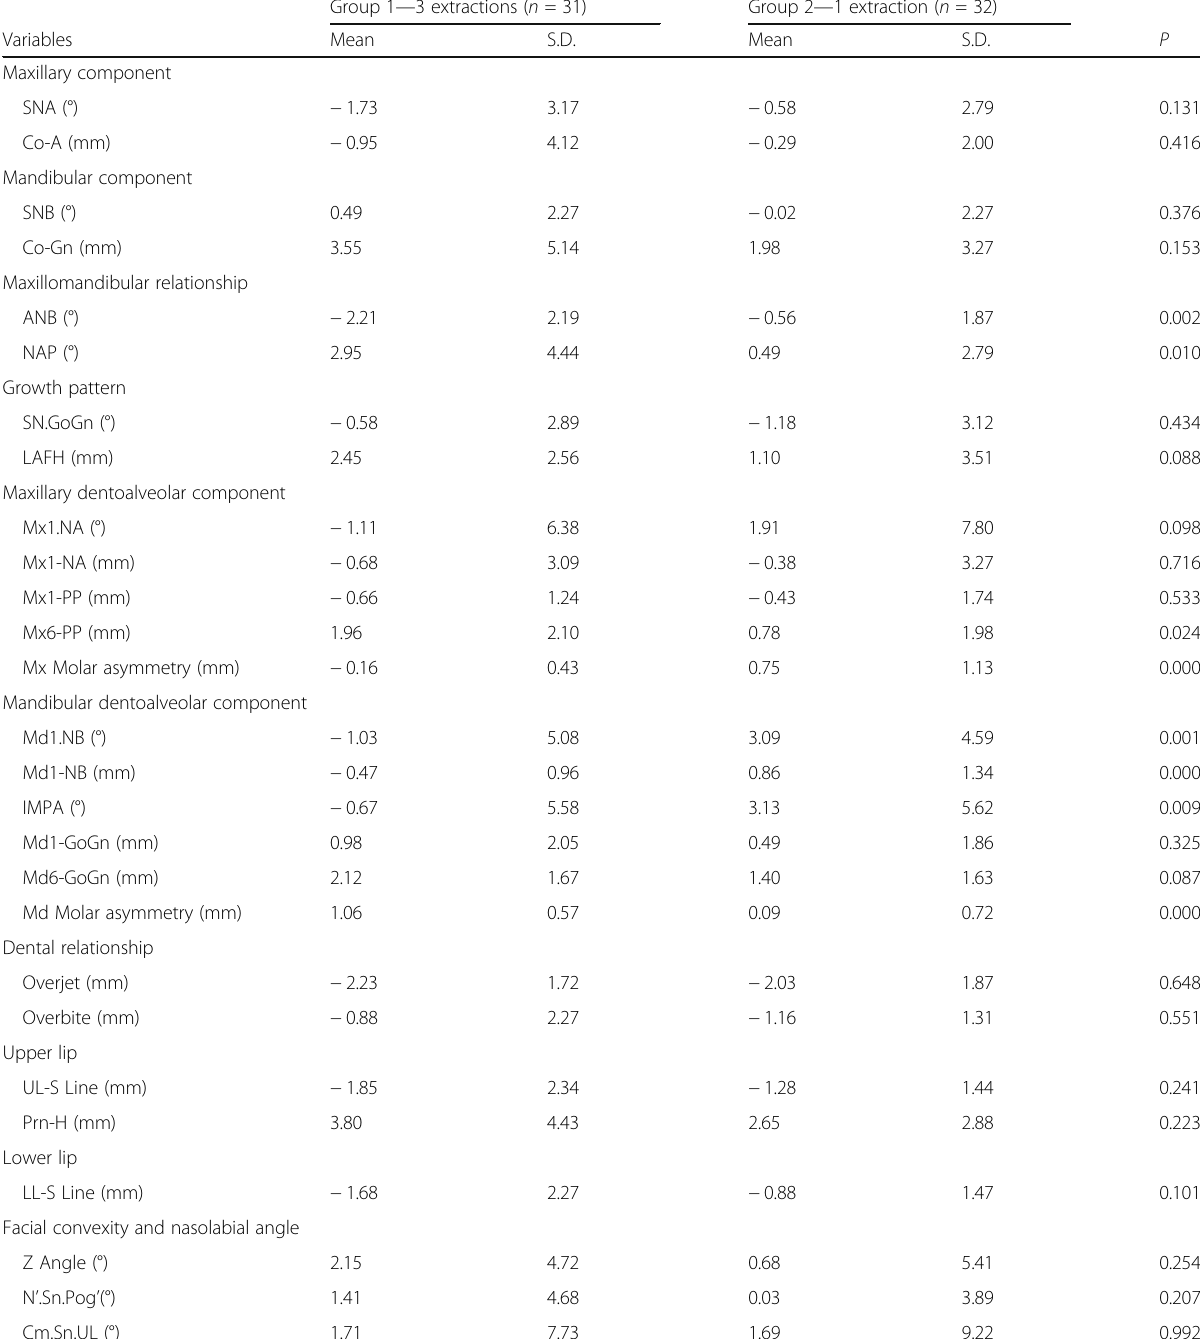
Table 4 Intergroup comparison of treatment changes ( t tests) Group 1 — 3 extractions ( n =